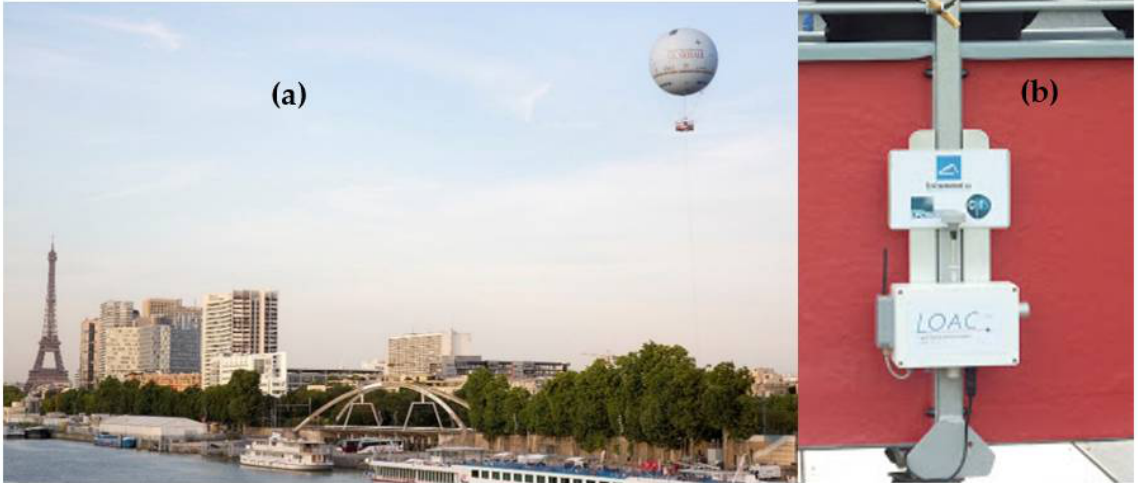
Figure 1. ( a ) Generali balloon above the André Citroën park in Paris; ( b ) the LOAC attached to the Generali balloon (We own this image, it is free to use under the creative commons license: https://creativecommons.org/licenses/by-sa/4.0/deed.en).